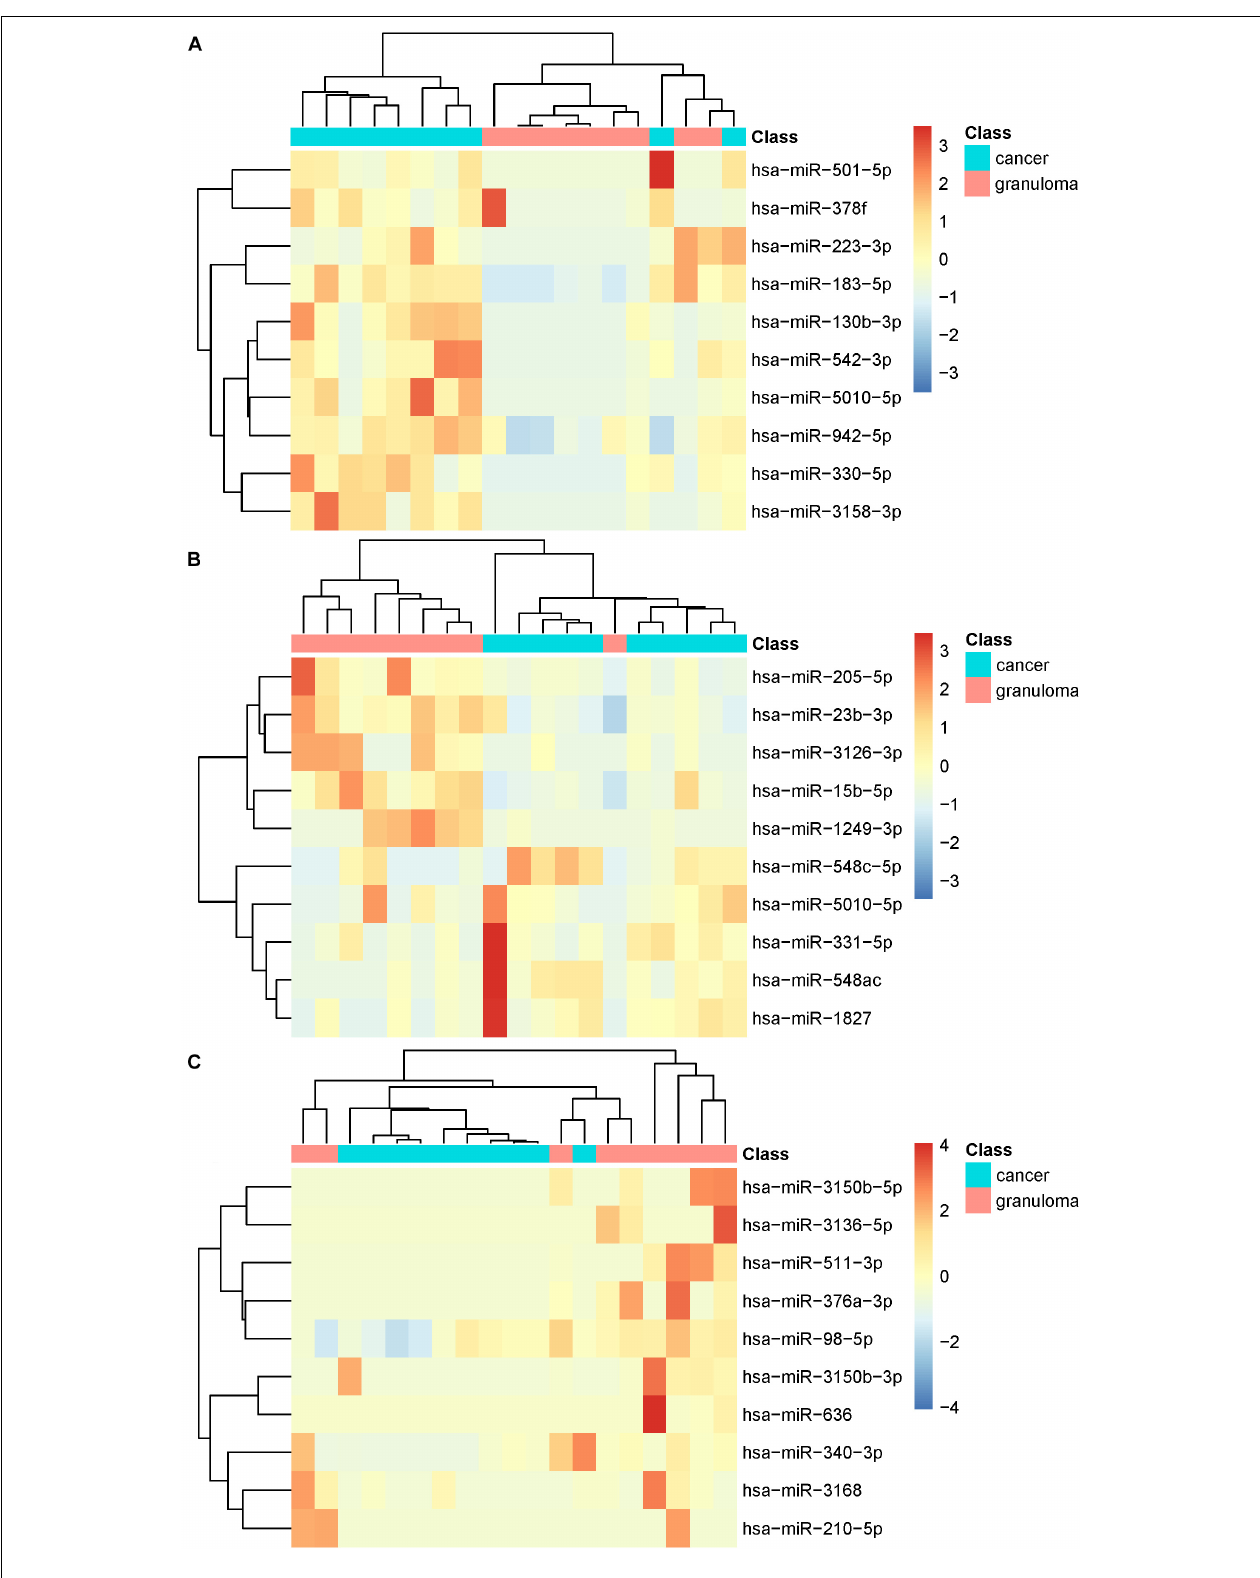
FIGURE 1 | The heatmaps of top 10 microRNAs in whole plasma, EV, and EV-free plasma. (A) For whole plasma, there were two miss clustered cancer patients; (B) for EV, there was one miss clustered granuloma patient; (C) for EV-free plasma, the cluster pattern was not clear.